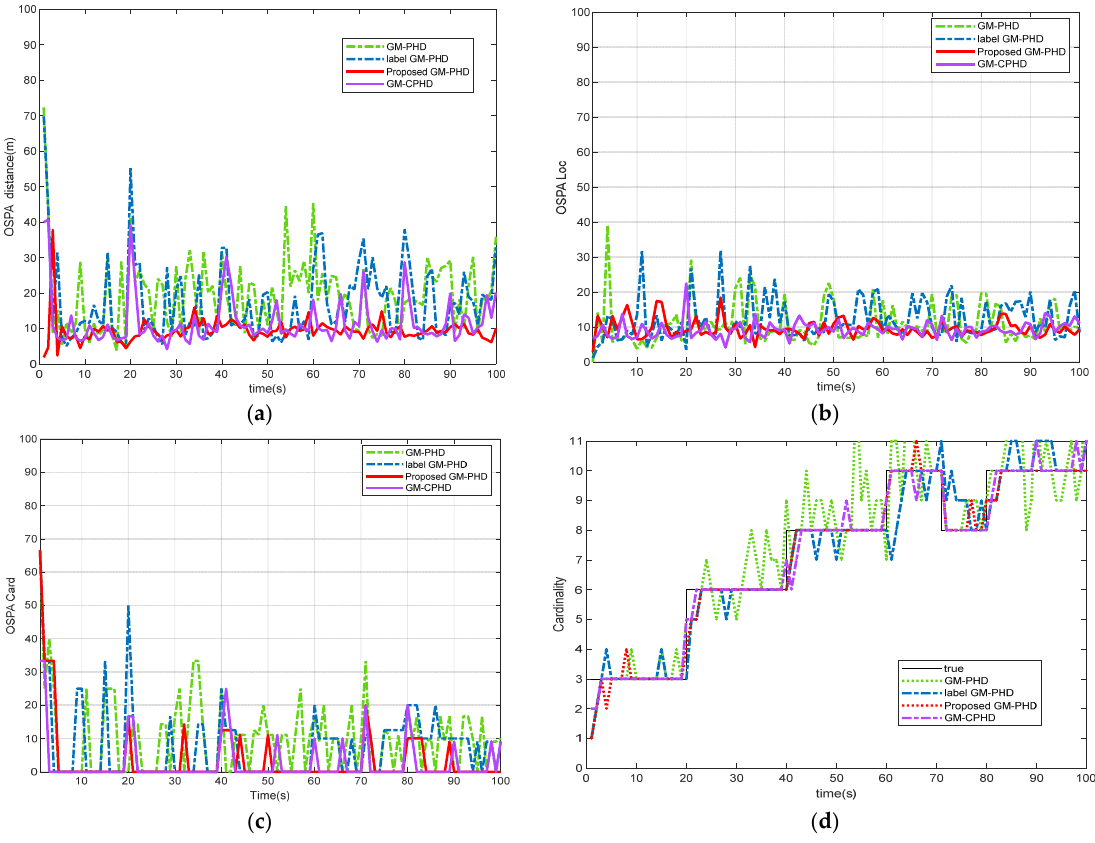
Figure 2. Performance comparison of different algorithms in dense clutter and high detection probability environment: ( a ) OSPA distance comparison; ( b ) OSPA Location comparison; ( c ) target cardinalities estimation error; ( d ) estimated cardinalities of targets.